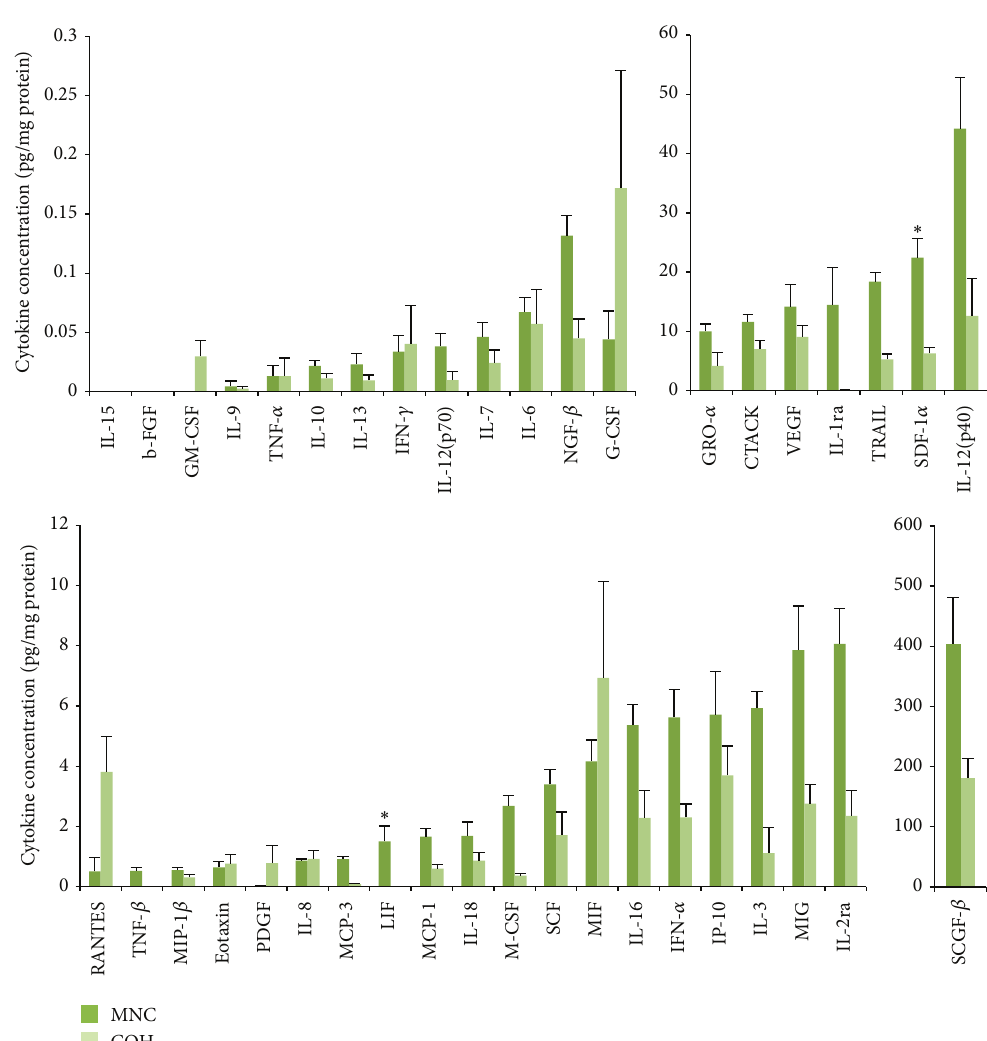
Figure 1: Mean ( ± SEM) FF cytokine concentrations in MNC ( 𝑛 = 9 ) and COH ( 𝑛 = 10 ) cycles ( ∗ significant difference from COH cycle; 𝑃 < 0.05 ).